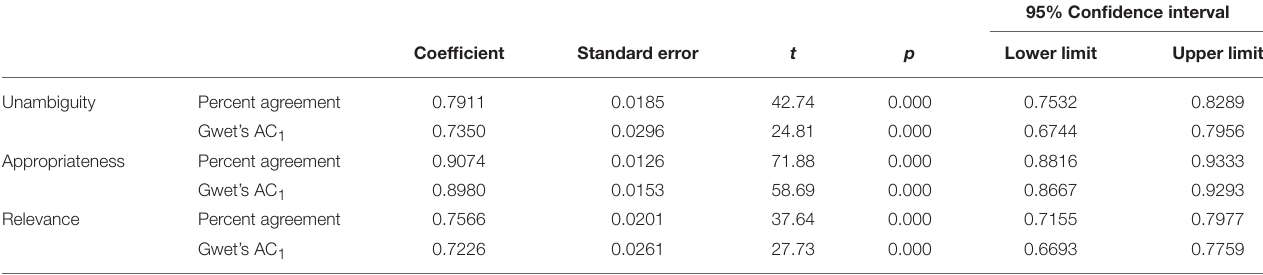
TABLE 2 | Measures of inter-rater agreement with standard errors and confidence intervals.